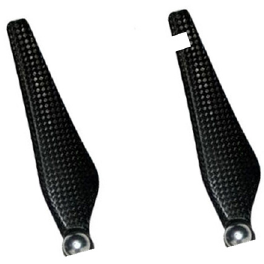
Figure 4. Schematic of Propeller configurations; stock blade ( left ) and notch or cut at leading edge of blade ( right ) [20].